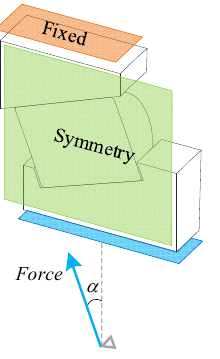
Figure 16. Boundary conditions of the sub-model.